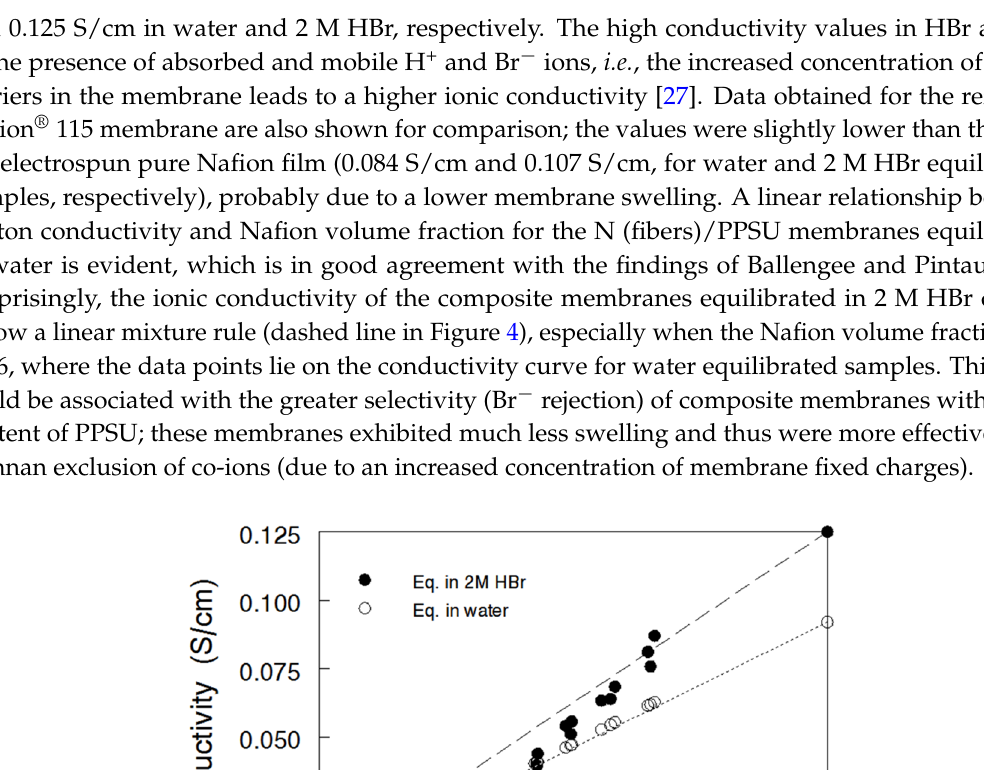
Figure 5. Fit of experimental data to the transient breakthrough model for: ( a ) Nafion ® 115; and ( b ) 57 vol% N (fibers)/PPSU nanofiber composite membrane. Figure 5a adapted with permission from ECS Transactions, 50 (2) 1217 (2012). Copyright 2012, The Electrochemical Society. Br 2 /Br 3 ‐ diffusion coefficients of all nanofiber composite membranes are plotted in Figure 6a as a function of Nafion volume fraction. An increase in membrane PPSU content led to a significant reduction in the Br 2 /Br 3 ‐ diffusion coefficient, from 1.90 × 10 − 6 cm 2 /s for pure electrospun Nafion to 2.20 × 10 − 9 cm 2 /s for the membrane with 75 vol% PPSU. Comparing the above data with the diffusion coefficient obtained for N (fibers)/PVDF membranes in [18], it can be concluded that replacing the